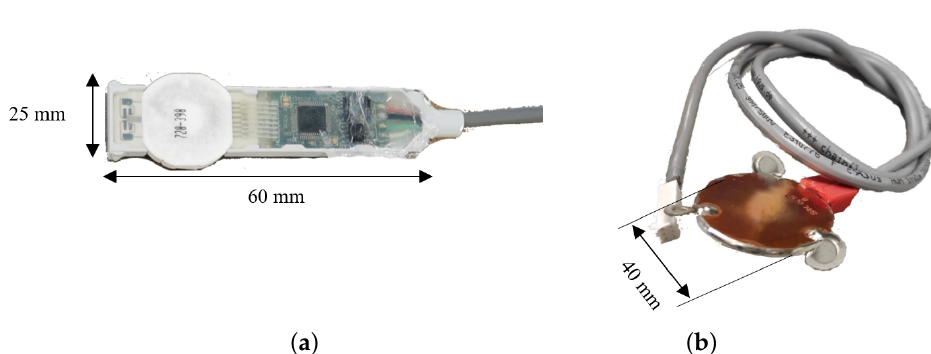
Figure 1. Innovative stress sensors: ( a ) Ceramic. ( b ) Capacitive.